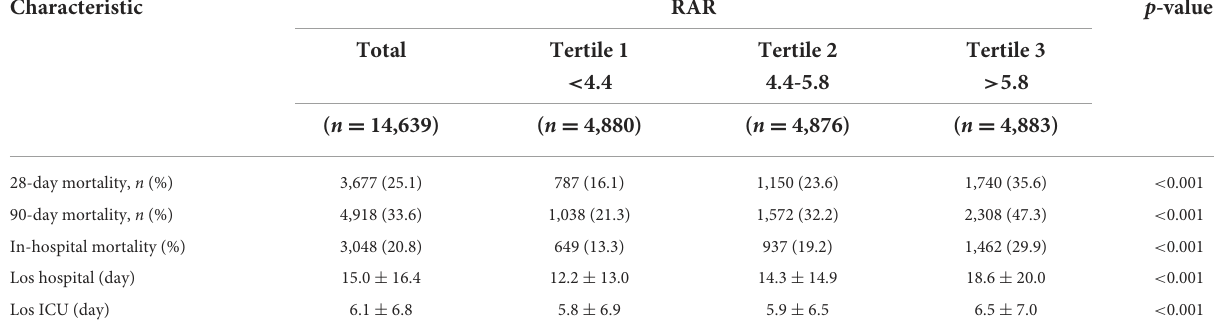
SOFA score, and SAPS II score were 0.633 (0.623, 0.644), 0.614 (0.604, 0.625), 0.602 (0.591, 0.613), 0.603 (0.593, 0.614), and 0.726 (0.717, 0.735), respectively. In addition, the AUC (95% CI) for RAR combined with SOFA score or SAPS II score was 0.656 (0.646, 0.667), 0.743 (0.733,